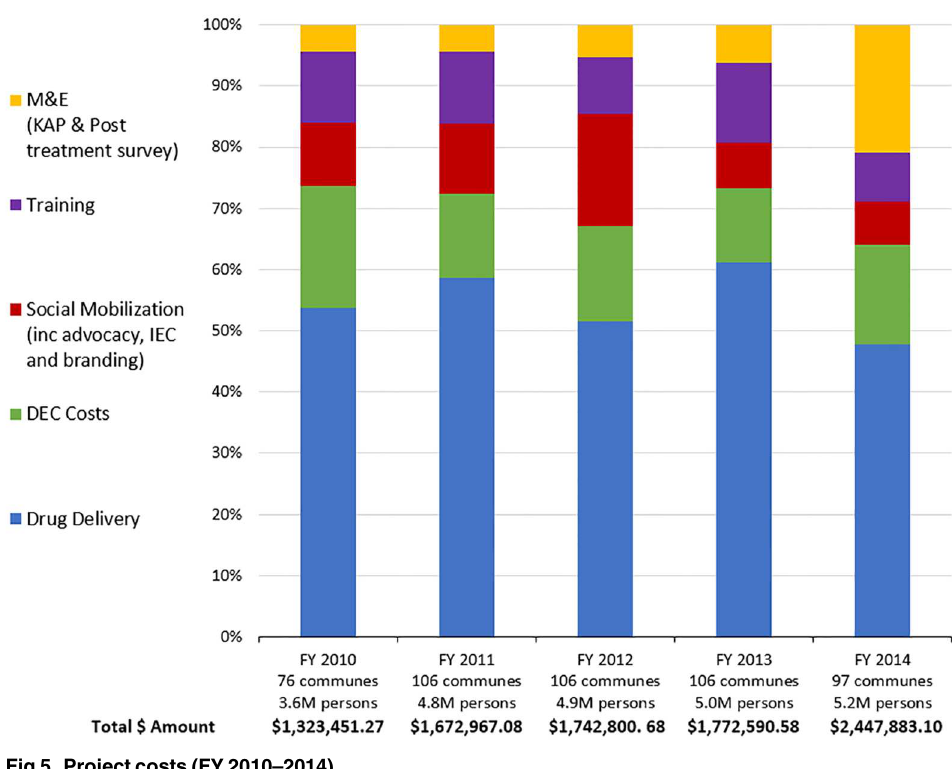
Fig 5. Project costs (FY